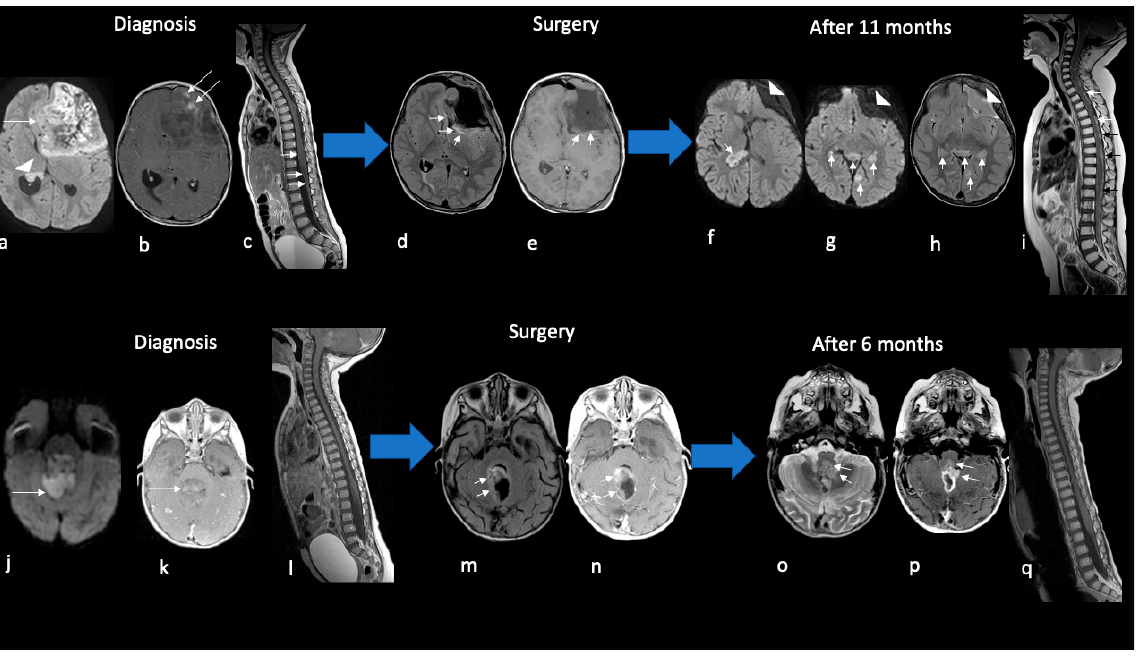
Figure 4. Imaging findings of disease progression in children with ATRTs. Ax DWI ( a , f , g , j ); Ax T1w ( e ); Ax T1w+mdc ( b , k , n , p ); Sag T1+mdc ( c , i , l , q ); Ax FLAIR ( d , h , m ); Ax T2w ( o ). An about 2-year-old child with frontal ATRT ( a – i ). At diagnosis, axial DWI MR shows reduced diffusivity of ATRT at the primary site in the frontal lobe (arrow in ( a )) and at metastases in the lateral ventricle (arrowhead in a); mild enhancement is present (arrows in ( b )). Sagittal T1+mdc MR of the spinal column shows leptomeningeal enhancement along the spinal cord (arrows in ( c )). Gross total resection was performed after 10 days showing a large surgical cavity with parenchymal reactive alterations but without apparent local disease residue (arrows in ( d , e )). After 7 months from surgery, the surgical cavity is collapsed (arrowheads in ( f – h )); note the increase of both intracranial metastases in ventricles and perimesencephalic cistern (arrows in ( f – h )) and spinal dissemination with nodular leptomeningeal foci (arrows in ( i )). The patient died after 20 months. An about 1-year- old child with posterior cranial fossa ATRT ( j – q ). At diagnosis, axial DWI MR shows reduced diffusivity of ATRT centered in the cerebellar vermis and filling the IV ventricle (arrow in ( j )); mild enhancement is detected after gadolinium (arrow in ( k )) but neither intracranial nor spinal metastases are noted. Gross total resection was performed after 6 days showing the surgical cavity margined by parenchymal reactive alterations (arrows in ( m , n )) without local disease residue. After 4 months from surgery local recurrence appears along the left anterolateral border of the surgical cavity (arrows in o-p) while no spinal dissemination is detected. The patient died after 9 months. Gross total resection was achieved in four pediatric patients, while subtotal resection was achieved in seven patients (six children and one adult). Ten out of eleven patients received chemotherapy, of which three patients also had high-dose chemotherapy and autologous hematopoietic stem-cell transplantation (two pediatric and one adult); only two patients also received RT (one child and one adult). Most of the patients died in four– nine months, while those patients treated with high-dose chemotherapy and radiotherapy had a longer outcome after diagnosis, although one of them was in disease progression. The only pediatric patient who did not receive therapy died after 20 days (Table 1, Figure 4). 4. Discussion ATRT is a rare pediatric tumor, and it is even more rare in adults. Because imaging characteristics of ATRTs may overlap with other CNS tumors, preoperative diagnosis of ATRTs are a challenge and they are often misdiagnosed. The available clinical literature mainly consists of reviews of case series reporting clinical features and outcomes both in